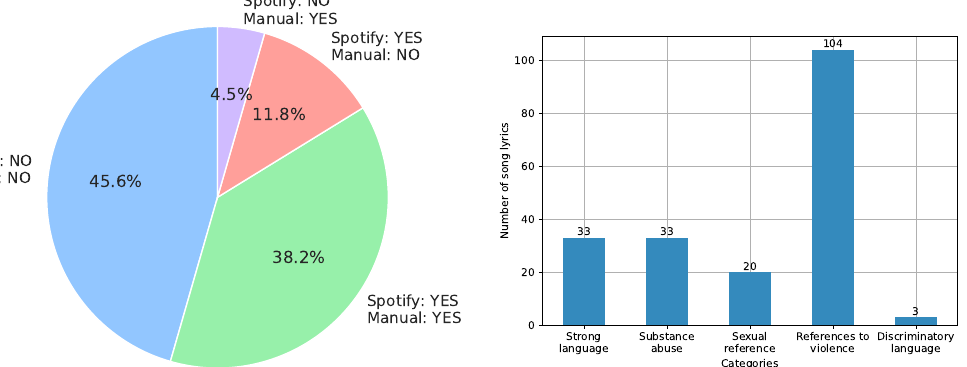
Figure 2. Partitioning of the song lyrics of the dataset according to the explicit (YES)/non-explicit (NO) information available on Spotify and our manual annotation ( left ); distribution of the reasons for the explicitness of their lyrics for the dataset songs that were “missing” the explicit tag on Spotify ( right